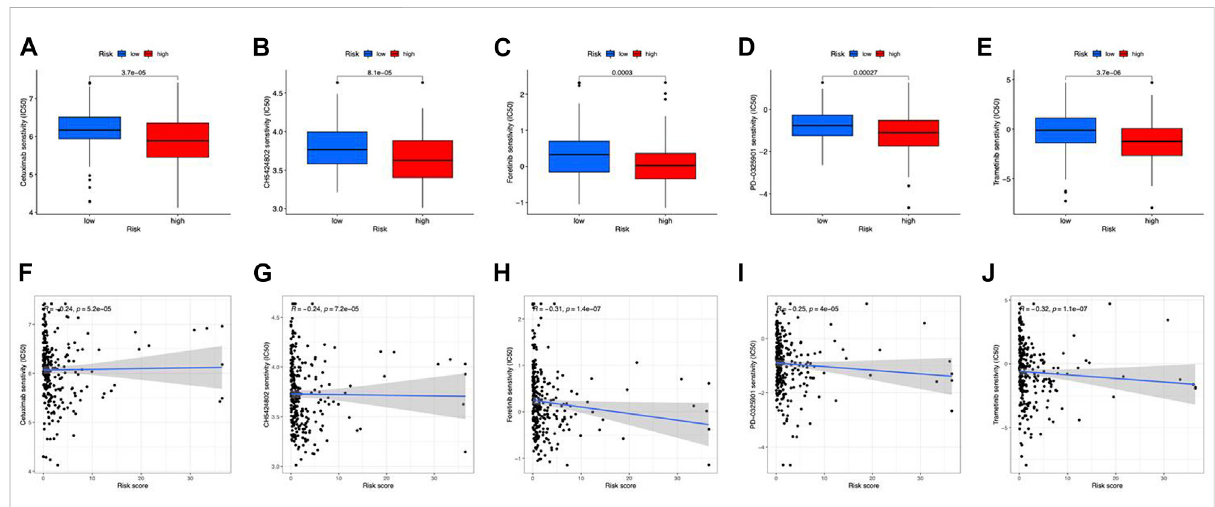
FIGURE 9 Drug susceptibility prediction. (A – E) Sensitive drugs in high-risk groups. (F – J) Correlation between sensitive drugs and risk